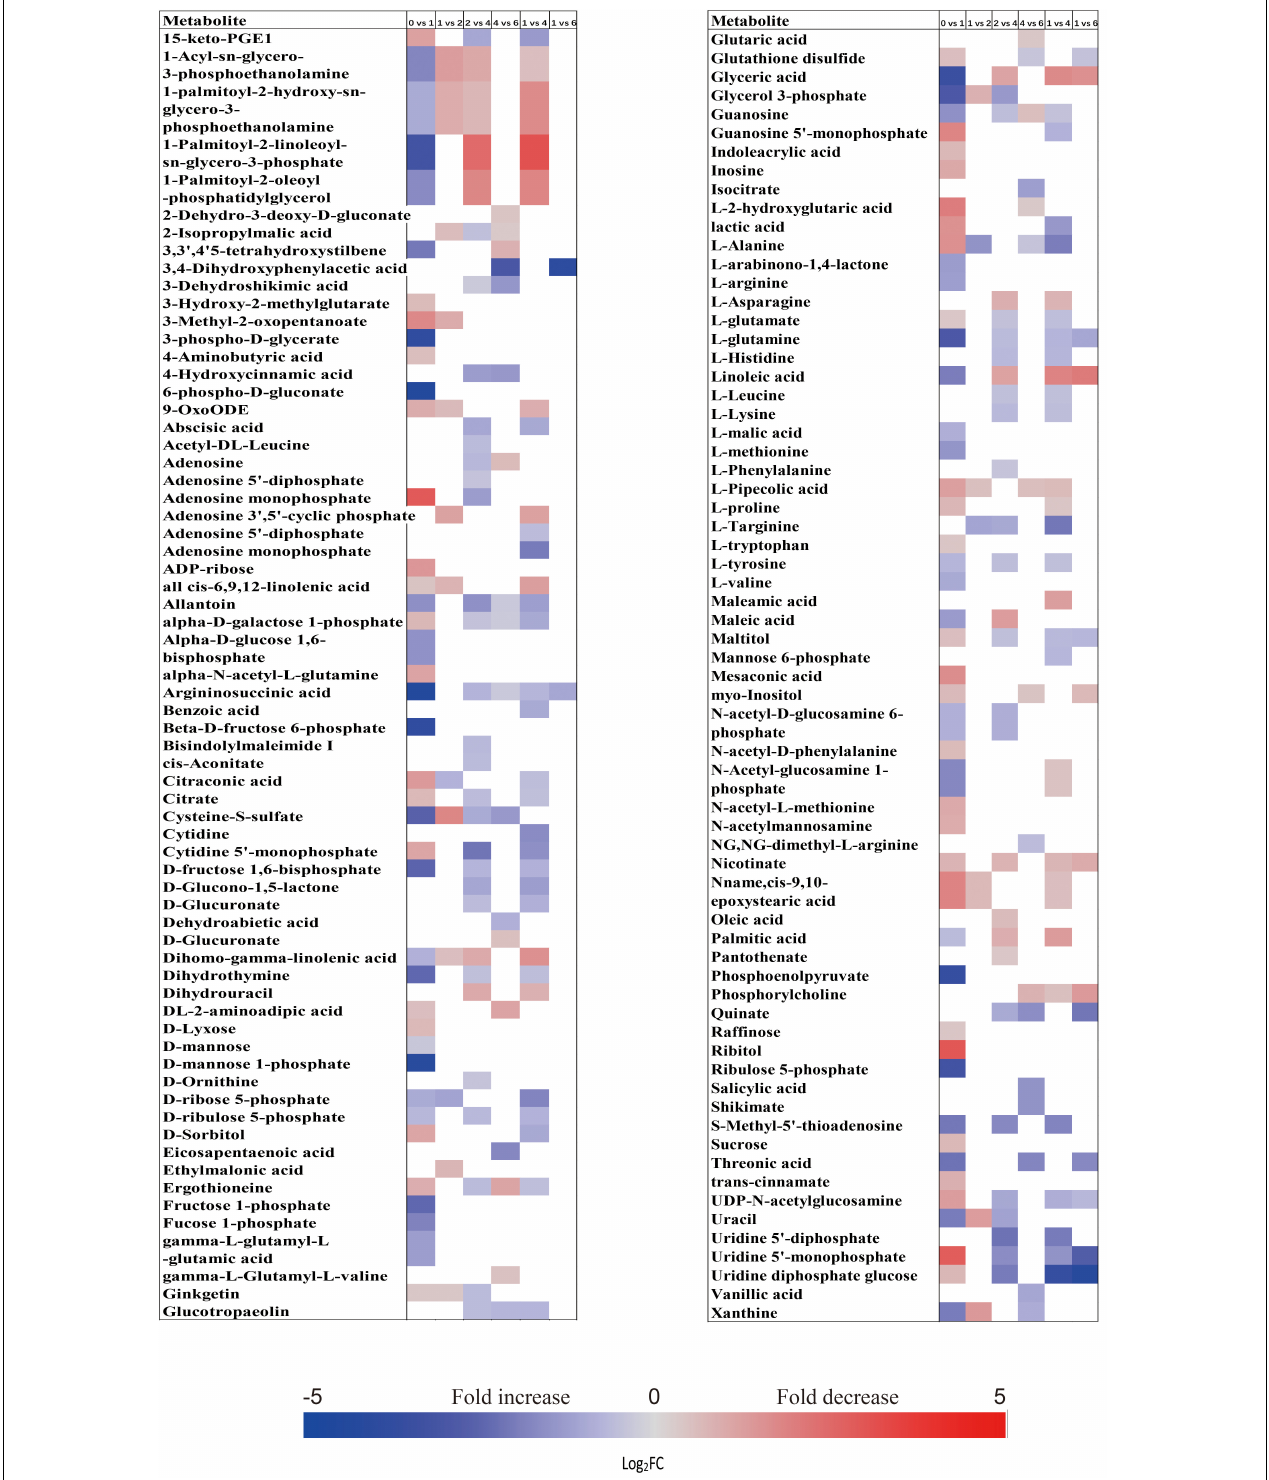
FIGURE 3 | Fold change in the relative contents of important metabolites with VIP value > 1 and P < 0.05 in the embryos of primary physiological dormant seeds between different incubation time points (0 week vs. 1 week, 1 week vs. 2 weeks, 2 weeks vs. 4 weeks, 4 weeks vs. 6 weeks, 1 week vs. 4 weeks, and 1 week vs. 6 weeks). Fold changes are represented as a heat map. White coloring indicates no significant change. VIP, variable importance in the projection.